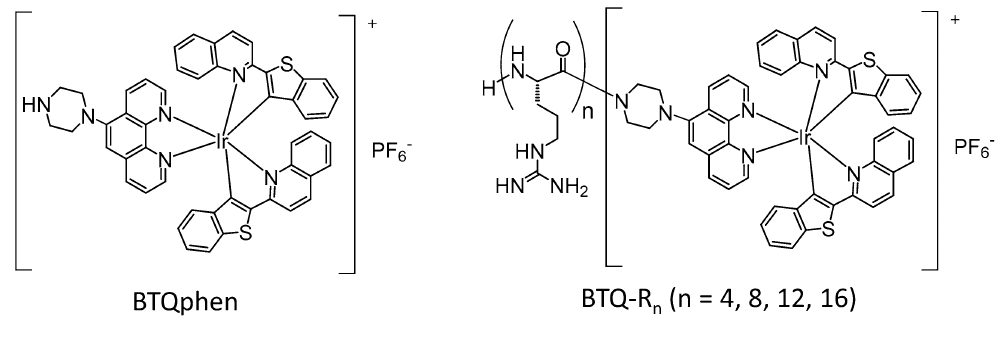
Figure 1. Chemical structures of BTQphen and BTQ-R n (n = 4, 8, 12,